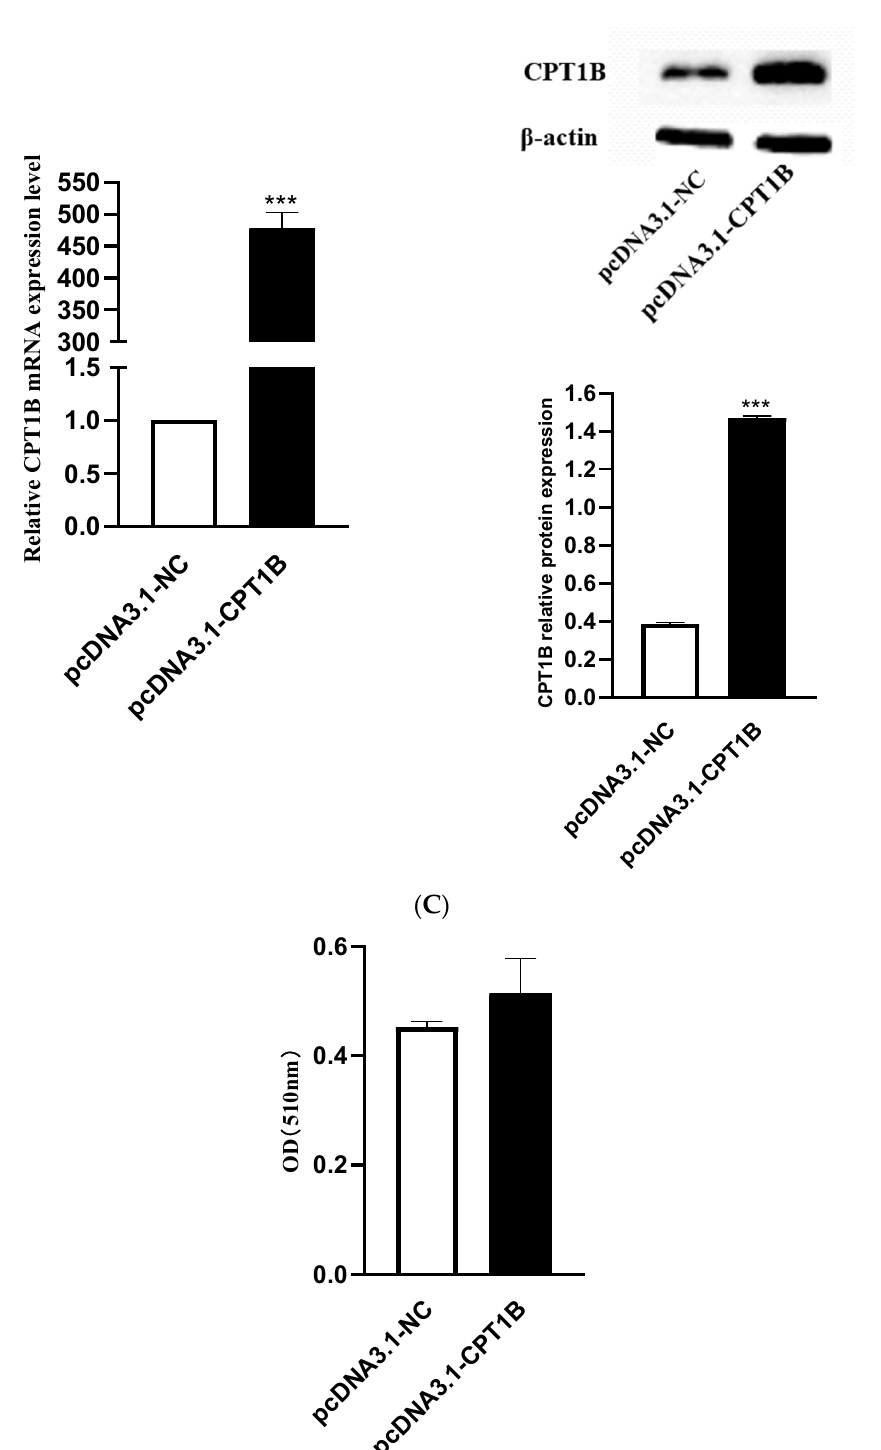
Figure 7. Effect of CPT1B on ovine preadipocytes differentiation. ( A , B ) Comparative expression of CPT1B mRNA and protein levels in ovine preadipocytes transfected with overexpression CPT1B vector and pcDNA3.1-NC for 48 h; ( C ) cellular lipid content as determined by spectrophotometry. *** p < 0.001.